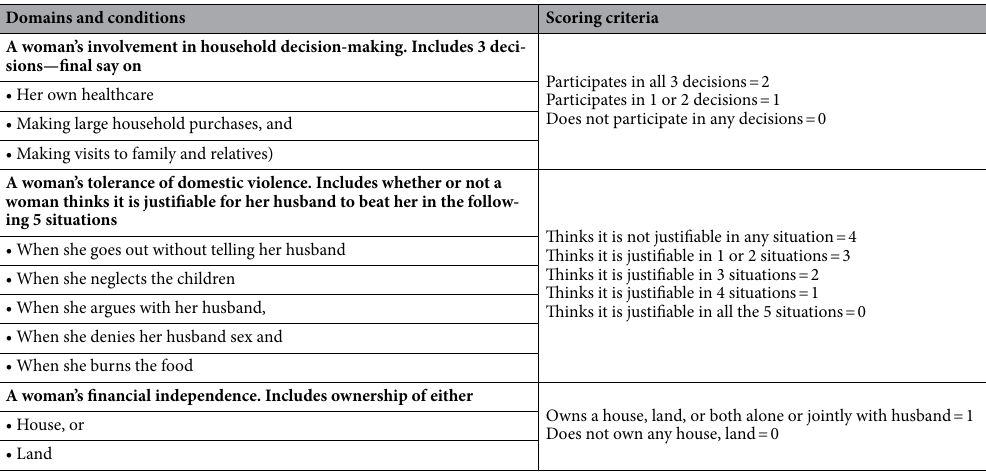
Table 1. Scoring of the three indicators used in the development of the maternal autonomy index. The range of maternal autonomy scores was 0–7, with 0–3 indicating low levels of maternal autonomy; 4–5 indicating moderate levels of maternal autonomy; and 6–7 indicating high levels of maternal